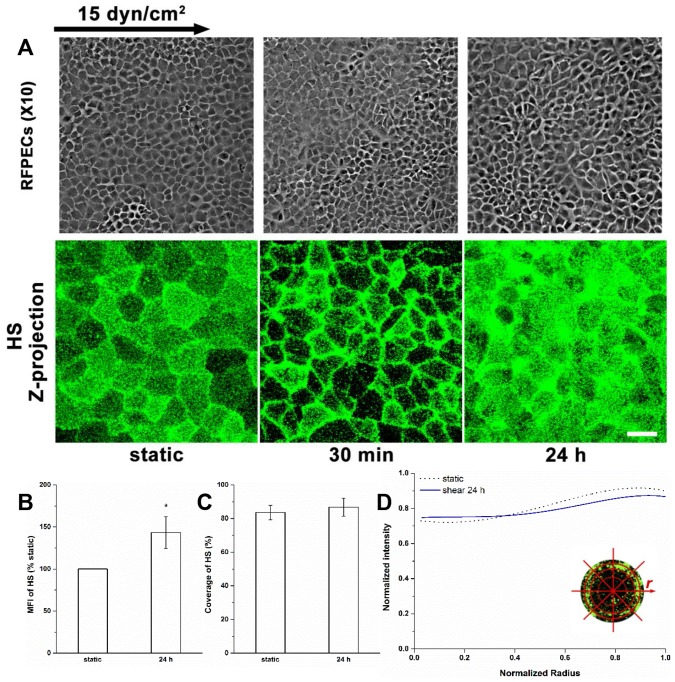
Restoration of HS after 24 h of shear exposure.(A) Top: Phase contrast micrographs of confluent RFPEC monolayers show that they fail to undergo change in cell shape under shear stress. Bottom: Representative immunofluorescent images of HS under static and shear stress conditions showing boundary clustering at 30 min and restoration of coverage at 24 h. (B) MFI (n = 16 images), (C) Coverage, and (D) Radial distribution of HS. The zero-radius represents the center of cell. The boundary of each cell was outlined by ImageJ. Then, the radial profile plug-in automatically changed the borders to the best-fit circles (D inset) for subsequent analyses. Scale bar: 20 µm. *P<0.05; **P<0.01.